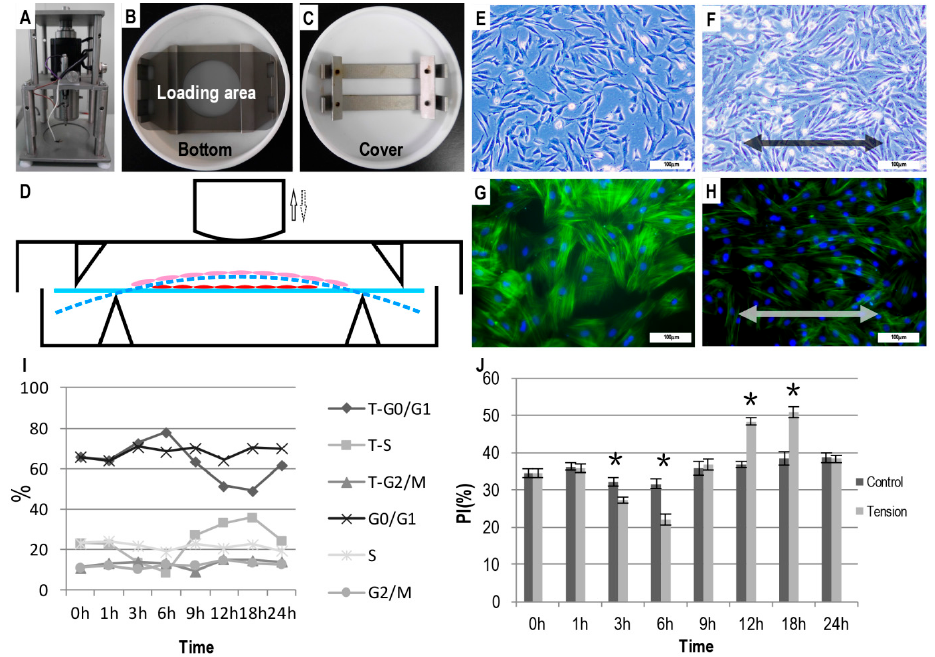
Figure 1. Illustration of the four-point bending apparatus and tensile stress on the morphology and proliferation of OCCM-30 cells (immortalized osteocalcin positive cementoblasts). ( A ) The Forcel ® four-point bending apparatus; ( B ) the stretching dish and ( C ) the force-loading plate; ( D ) Schematic graph depicting the administration of cyclic uniaxial tensile stress on the OCCM-30 cells. Light ( E , F ) or fluorescent ( G , H ) micrographs depicting the morphology and actin alignment of the cells with ( F , H ) or without cyclic tensile stress ( E , G ). The arrows in ( D ) indicated the direction of the cyclic pressure. The blue solid line and the blue dash line in ( D ) indicated the original and bended forms of cell culture plates under the cyclic tensile forces. The red and pink oblates indicated the cementoblasts that were upstretched or stretched under the cyclic tensile forces. Arrows in ( F ) and ( H ) indicated the direction of the cyclic tensile stress. Bar = 100 µm. Graphs depicting the results of flow cytometry analyses for the ratio of cell cycle phases ( I ) and the proliferation index (PI) ( J ) with or without tensile stress for certain durations. * p < 0.05.